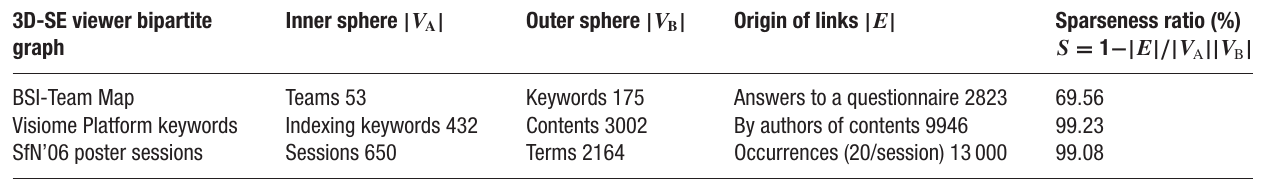
Table 1 . Basic figures of the three datasets used in the application of the 3D-SE viewer.